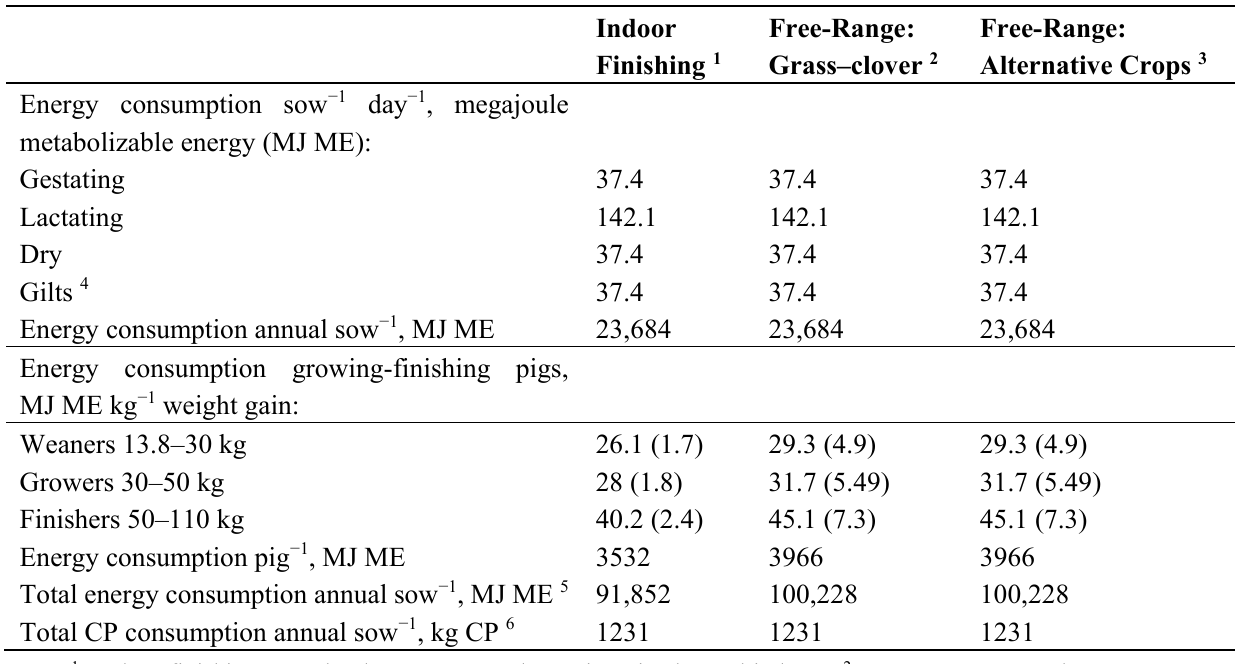
Free-Range: Grass–clover 2